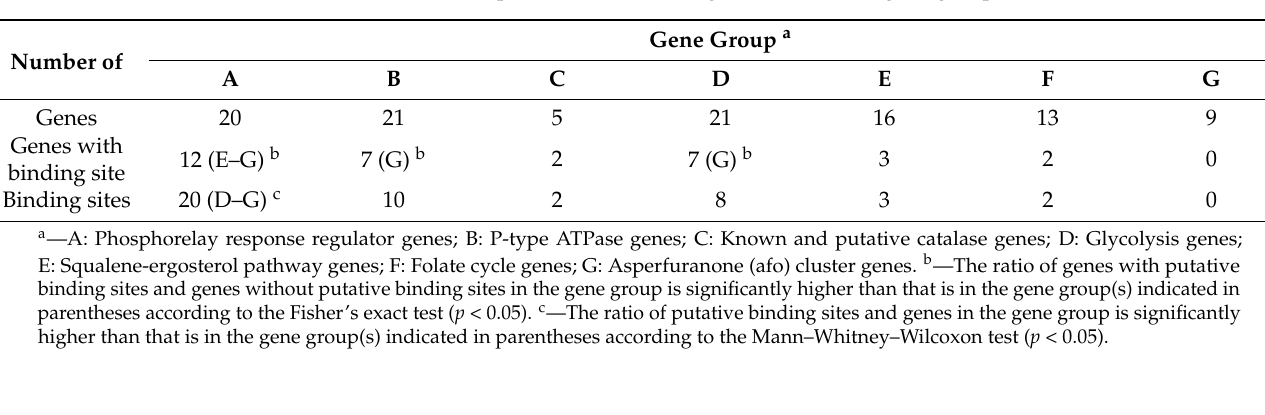
Figure 6. Distribution of stress responsive “Phosphorelay response regulator” genes between the THS30 reference strain and the TNJ92 ∆ atfA mutant ( A ) as well as of the AtfA-dependent “Phos- phorelay response regulator” genes between the untreated and CdCl 2 -treated cultures ( B ). Figures represent the number of up-regulated/down-regulated genes. Further data on the gene group are available in Table S5. Table 4. Abundance of putative AtfA binding sites in selected gene